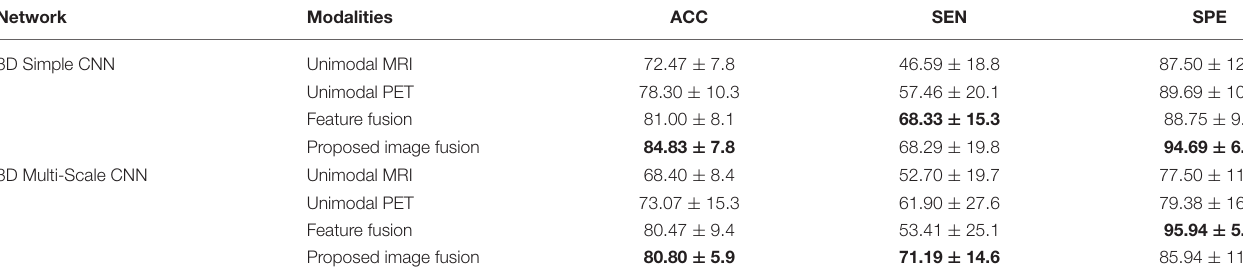
TABLE 4 | Results of different modalities with different networks for AD vs. MCI (UNIT:%).